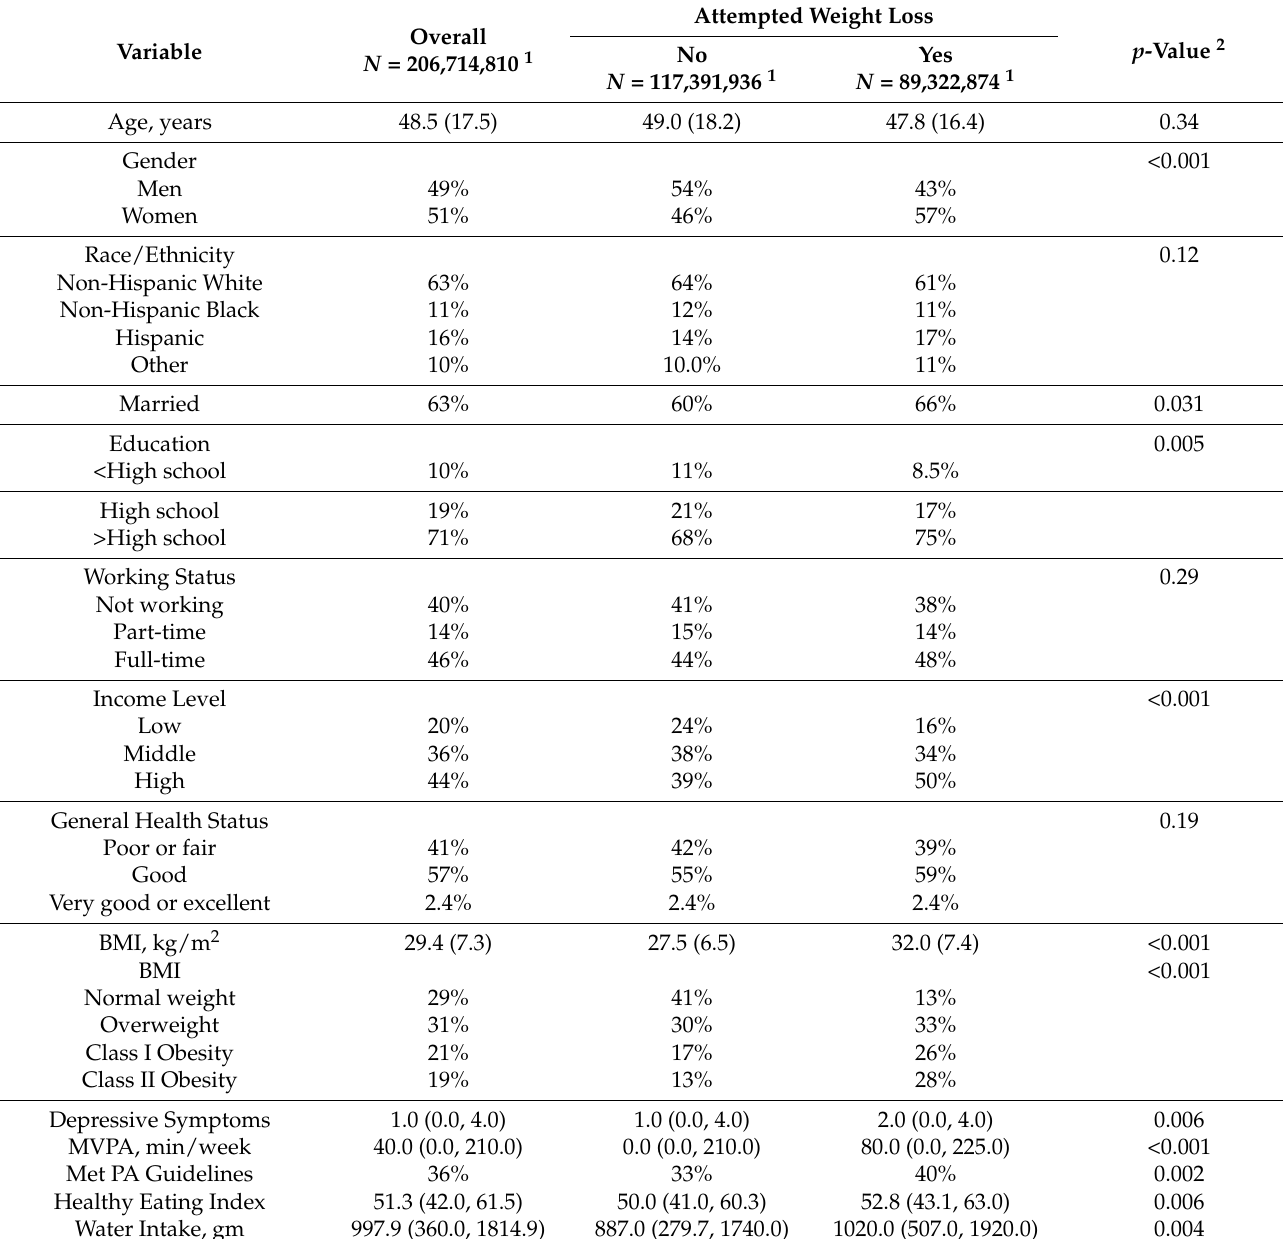
Table 1. Descriptive characteristics by weight loss attempt